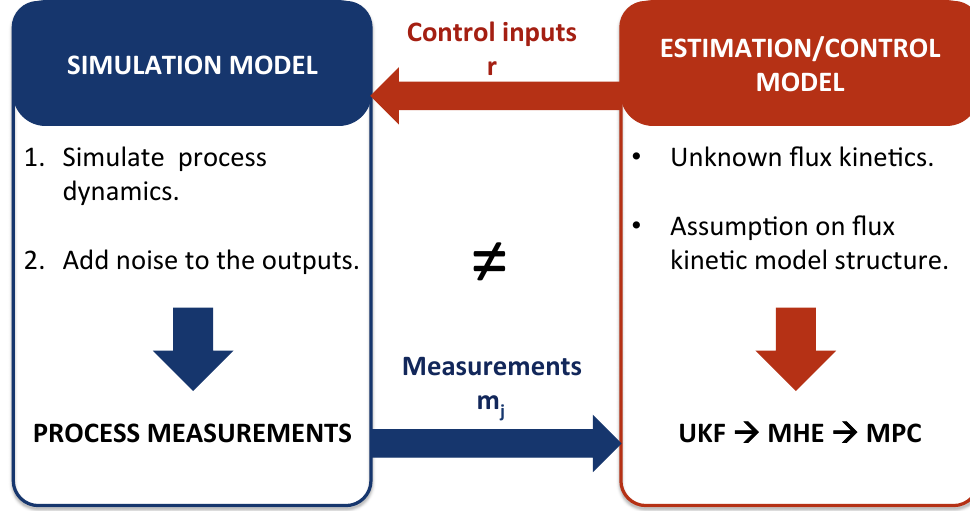
Figure 4. General setup with simulation model and estimation/control